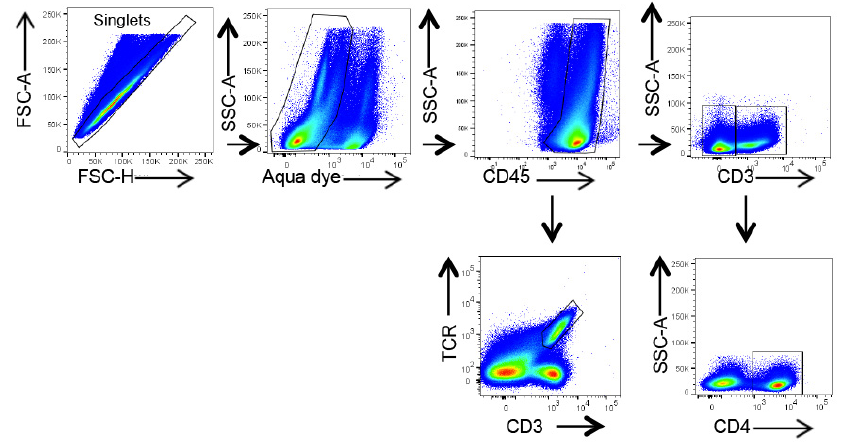
Figure 9. Gating strategy of γδ and CD4 + T cell subsets in the lung. Gating strategy included forward and side scatter gating, exclusion of multiplets, selection of living cells with aqua dead stain, and selection of cell subsets according to the indicated cell surface markers.